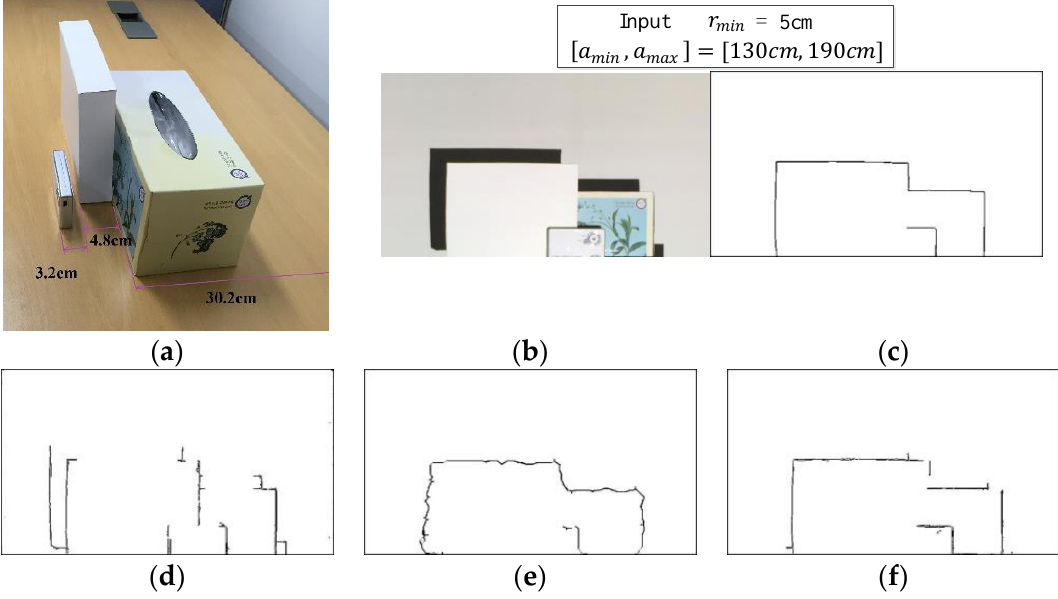
Figure 1. Depth edges, which have the minimum depth difference of 5 cm in the specified range of distances [130 cm, 190 cm] from the projector/camera, are detected in ( a ). The camera’s view is shown in ( b ). Depth edge filtering results are presented for ( c ) ground truth; ( d ) method in [8]; ( e ) Kinect, and ( f ) our method.